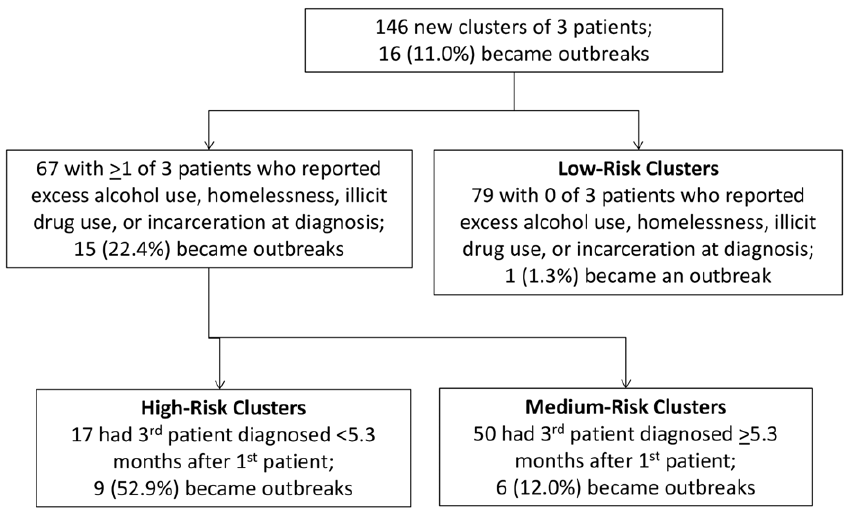
Figure 3. Algorithm based on decision-tree analysis for predicting TB outbreaks. Algorithm based on data available at time the TB cluster contained 3 cases. Decision-tree analysis categorizes clusters in high-, medium-, or low-risk groups. Clusters in the high-risk group are considered of greatest priority for early interventions, such as intensive contact investigations. Although clusters in medium- and low-risk groups may not be considered highest priority when they have 3 cases, they can be re-evaluated should additional cases occur.